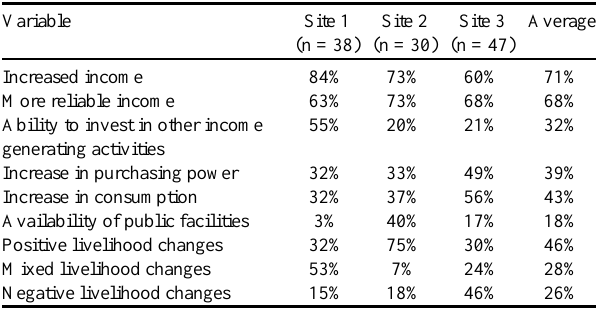
Table 11 . Perceived livelihood changes for employees.